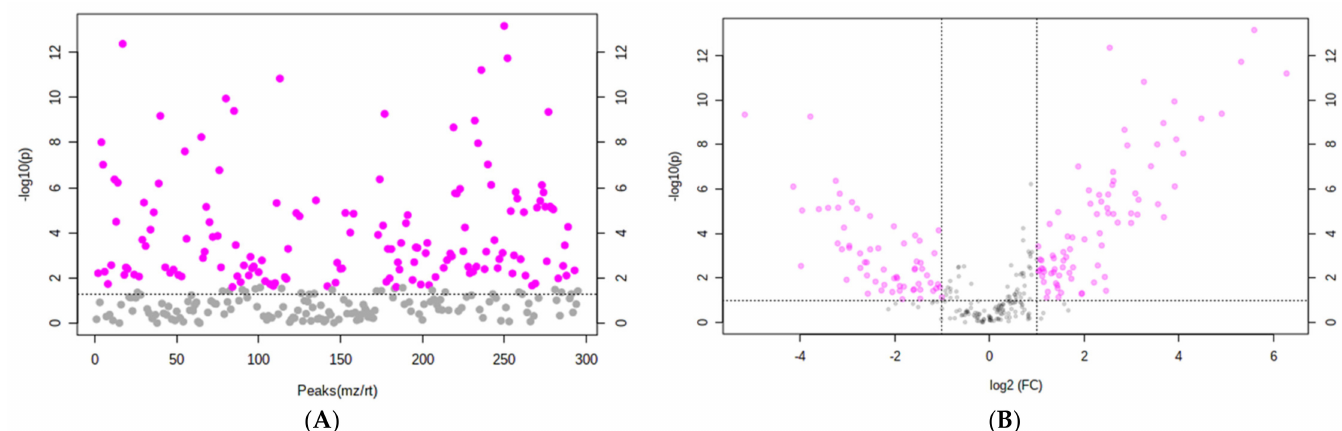
Figure 4. t -test and volcano plot analysis of the three lettuce cultivars under +S and − S conditions. ( A ): t -test, pink nodes represent important features selected by t -tests with threshold ( p -value) 0.05. ( B ): volcano plot analysis, pink circles represent metabolites selected by volcano plot with fold change threshold ( − S/+S) 2 and t -tests threshold 0.1. Both fold changes and p -values are